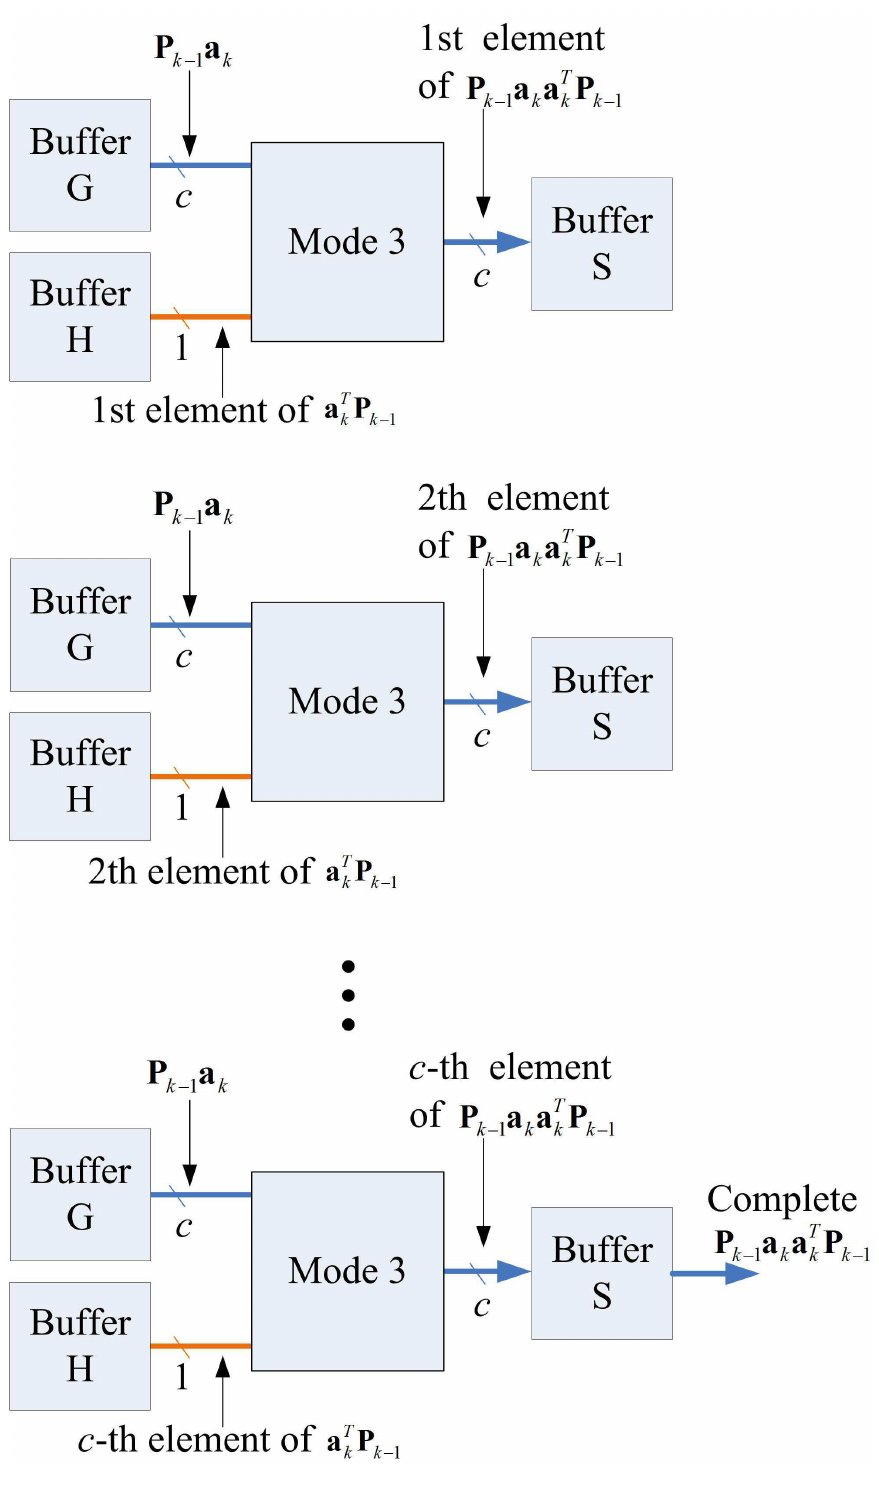
Figure 16. Multiple-step operations of state